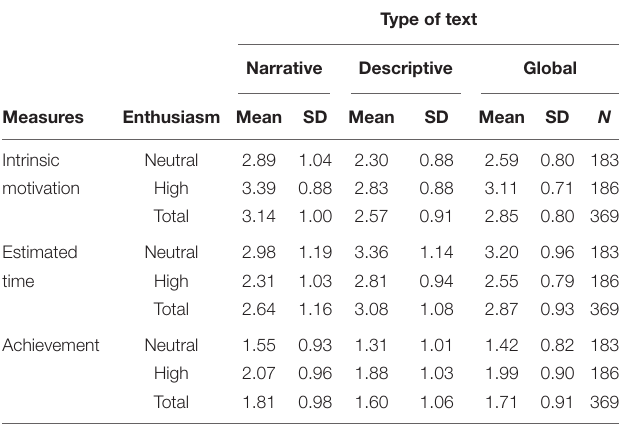
TABLE 1 | Descriptive data of the